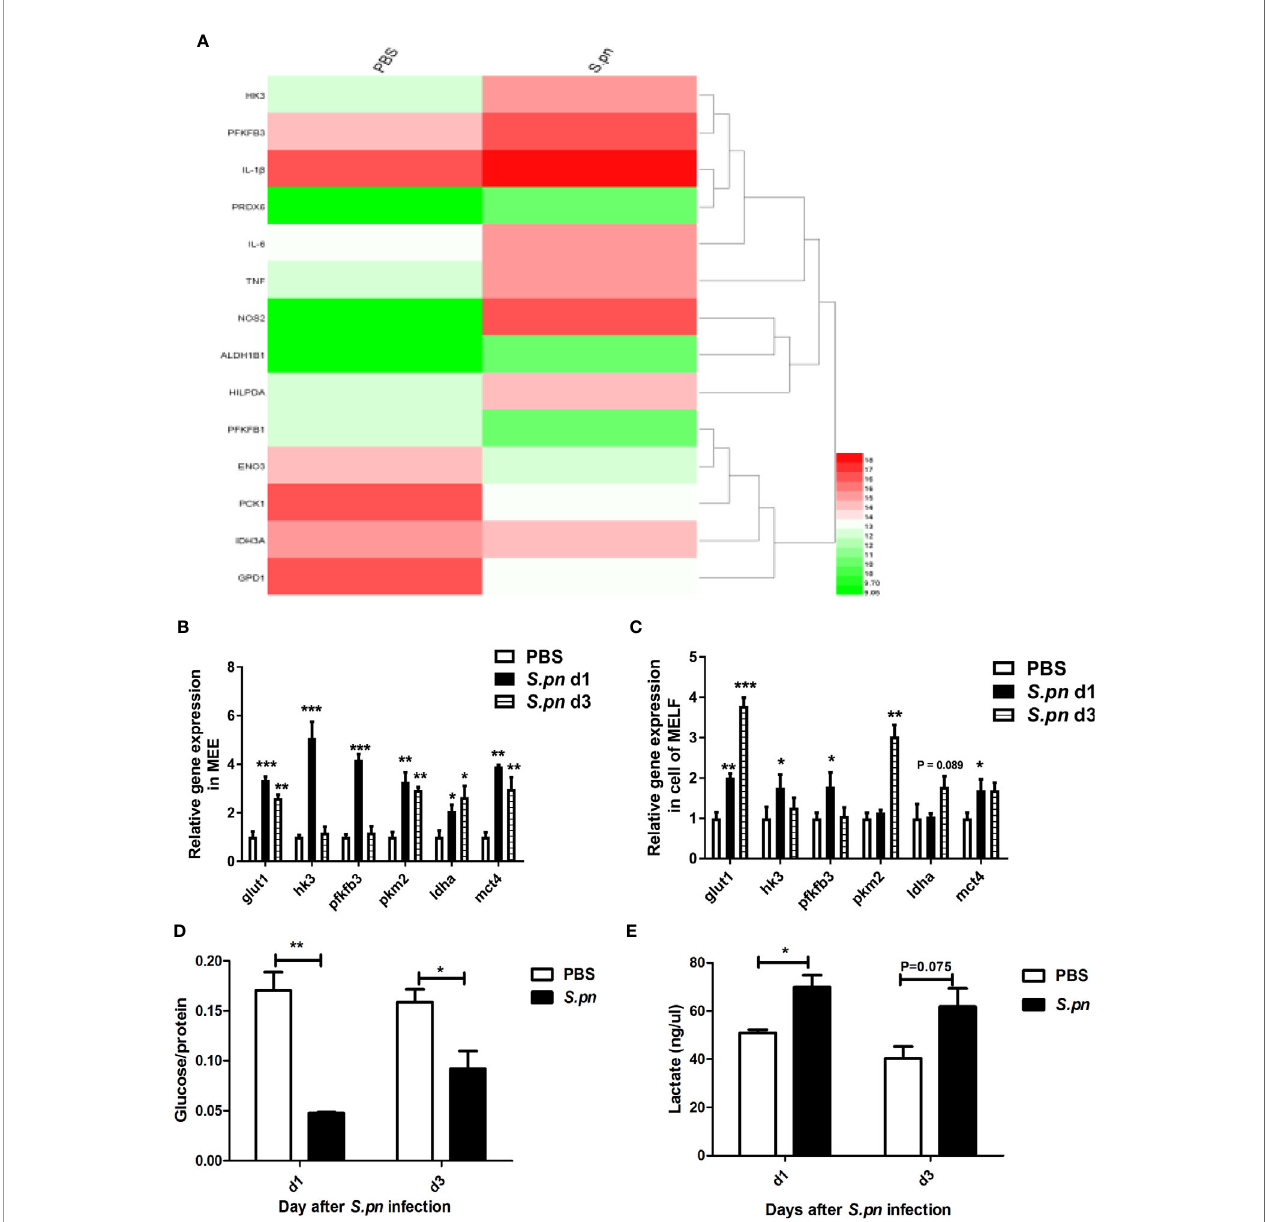
FIGURE 1 | Glycolysis increases in response to S.pn infection during AOM. (A) The expression of glycolysis-related genes in mouse middle ear was detected by microarray. Red to green on the heat map indicated the expression level was gradually downregulated. (B) The mRNA expression levels of glycolysis-related genes in middle ear epithelium and (C) , middle ear cavity in fl ammatory cells were veri fi ed by RT-qPCR at designated time points post-infection. (D) Levels of glucose and (E) , lactate in the supernatants of MELF were detected refer to the manual. Data represent three independent experiments and are presented as mean ± SD (n = 3). *P < 05; **P <.01; ***P <